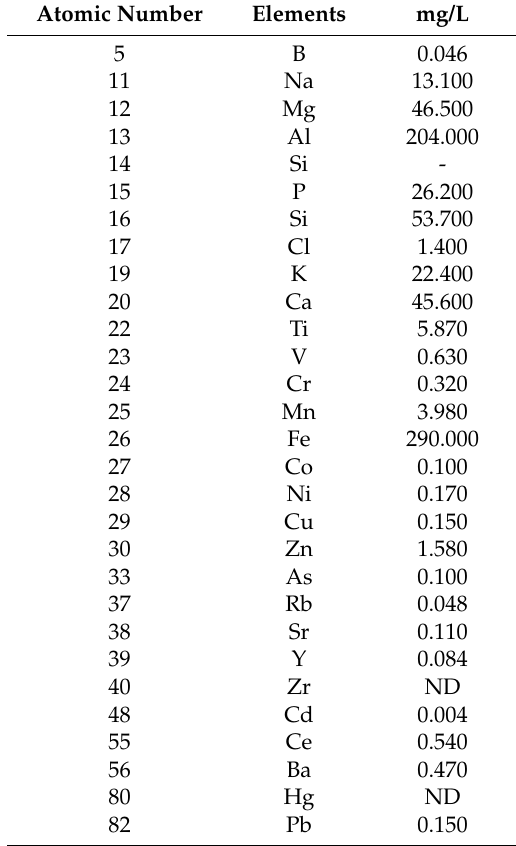
Table 2. ICP-MS semi-quantitative analytical results for dried colonies of Pectinatella magnifica collected from Kahokugata Lake. (The unit mg/L means the weight of the element in one liter of wet sample.) Atomic Number Elements mg/L 5 B 0.046 Na 13.100 Mg 46.500